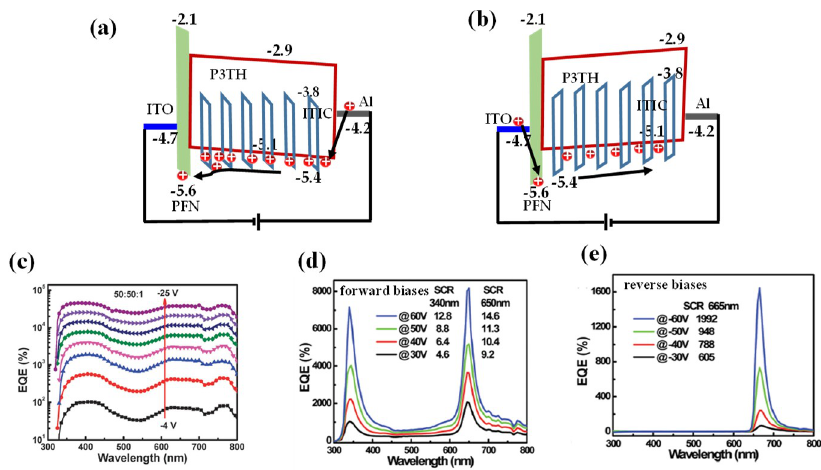
Figure 6. ( a , b ) Energy level diagrams of the PFN device under reverse forward biases under dark; ( c ) EQE spectra under different biases of the ITO/PEDOT:PSS/P3HT:PTB7-Th:PC 71 BM (50:50:1)/Al device (Reproduced with permission from [79]. Royal Society of Chemistry , 2015); ( d , e ) Narrowband EQE spectra of the ITO/PFN-OX/P3HT:PC 61 BM (4.0 µ m)/Al device under different biases (Reproduced with permission from [92]. Royal Society of Chemistry ,